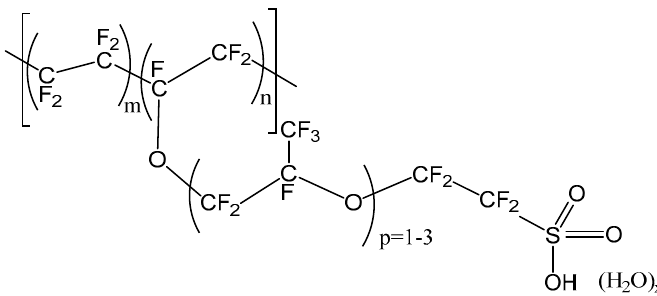
Figure 2. Chemical structure of Nafion.